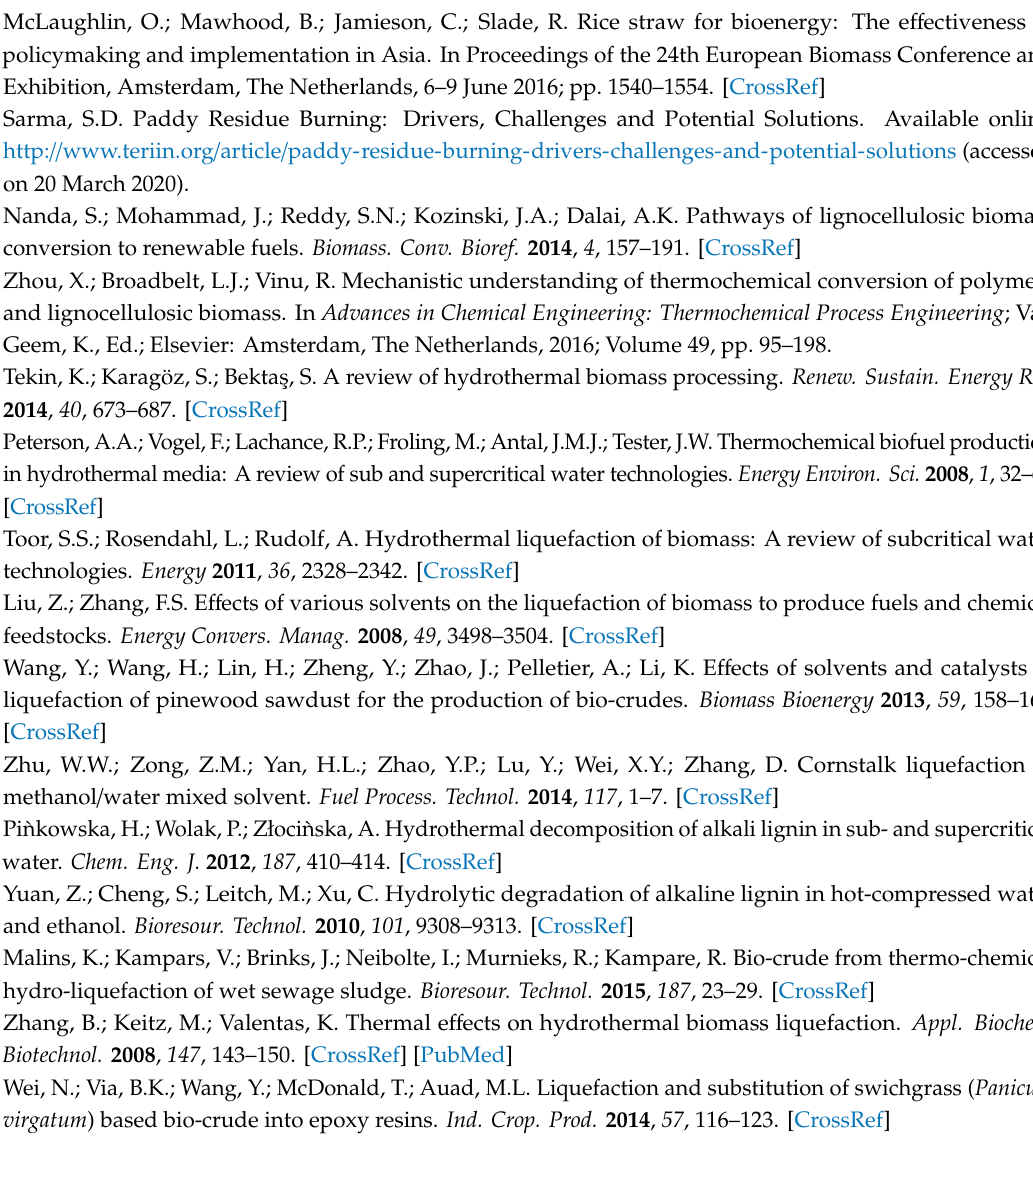
Figure S1: Temperature and pressure profiles from selected experiments performed at rice-straw-to-water ratio of 1:10 wt. / wt. Tables S1–S10: Detailed composition of bio-crude from experiments R1, R2, R4, R5, R10, R11, R12, R13, R14 and R15, respectively. S11: Sample calculation to determine energy recovery (%) and